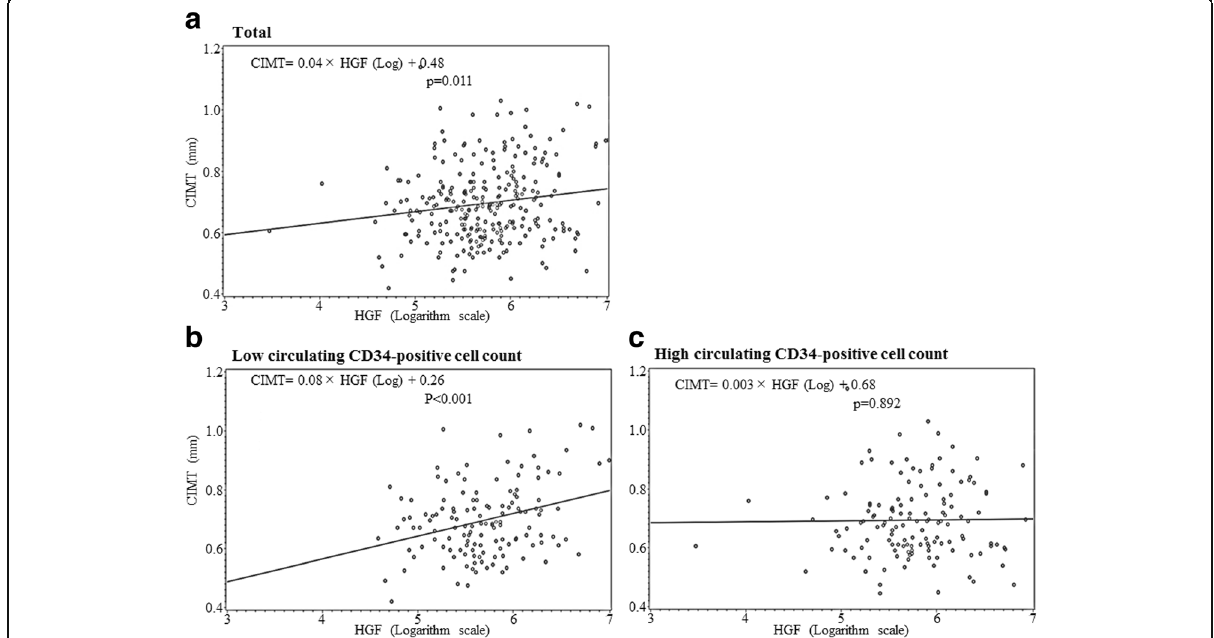
Fig. 1 Scatter plot of hepatocyte growth factor (HGF) and carotid intima-media thickness (CIMT) for participants with a total, b low circulating CD34-positive cells ( ≤ 0.93 cells/ μ L), and c high circulating CD34-positive cells (> 0.93 cells/ μ